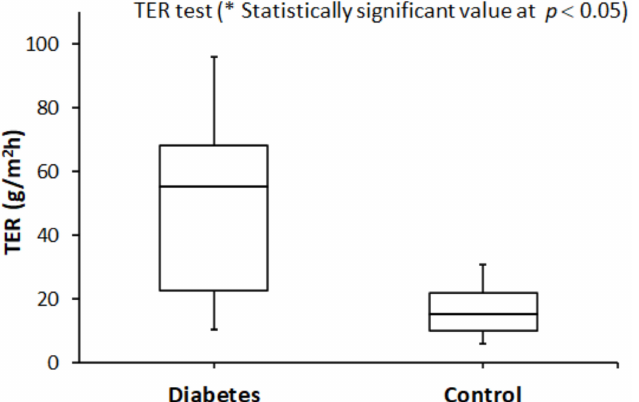
Figure 2. A side-by-side boxplot for the TER score within the study (diabetes) and the control (without diabetes) groups. * The difference in the TER median score was statistically significant at p < 0.05.